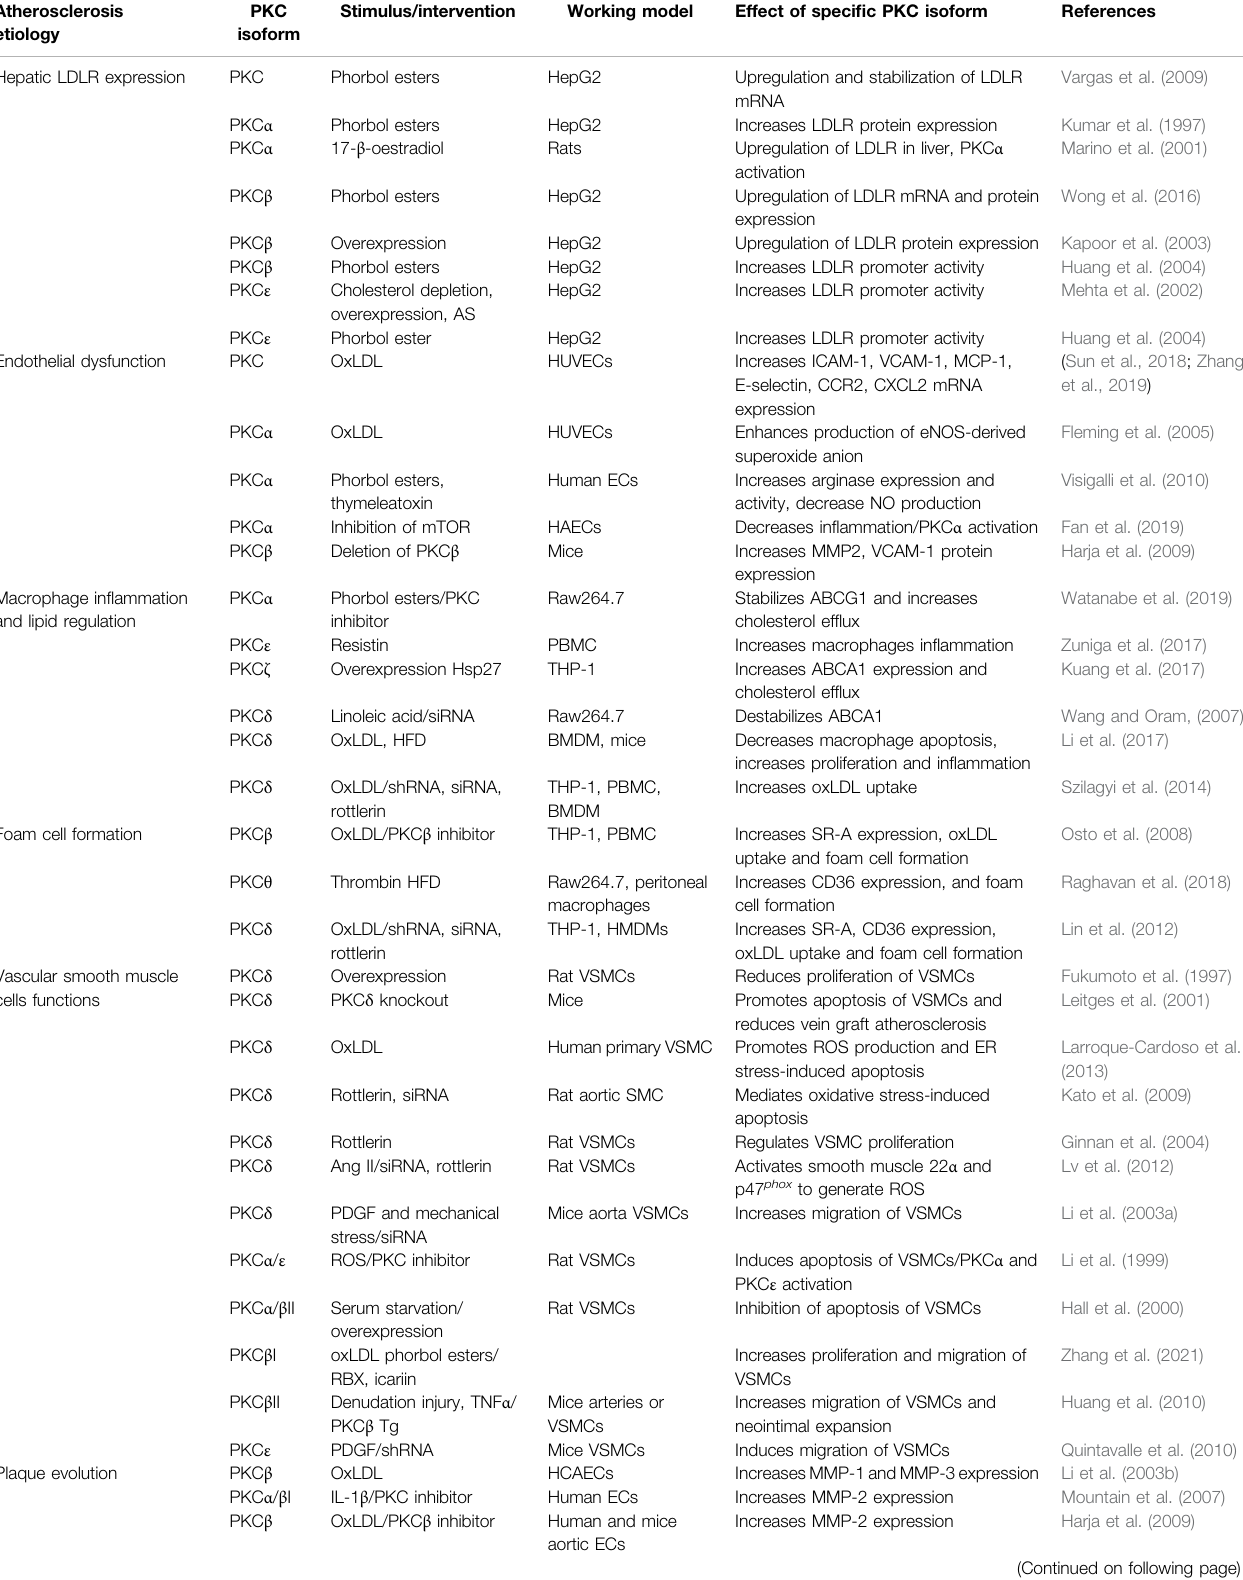
TABLE 1 | Summary of PKC isoform-speci fi c role in the progress of atherosclerosis. Atherosclerosis